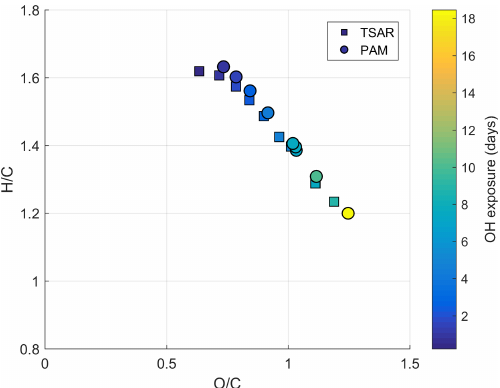
Figure 11. The van Krevelen diagram of toluene SOA for both chambers. The color indicates the OH exposure.